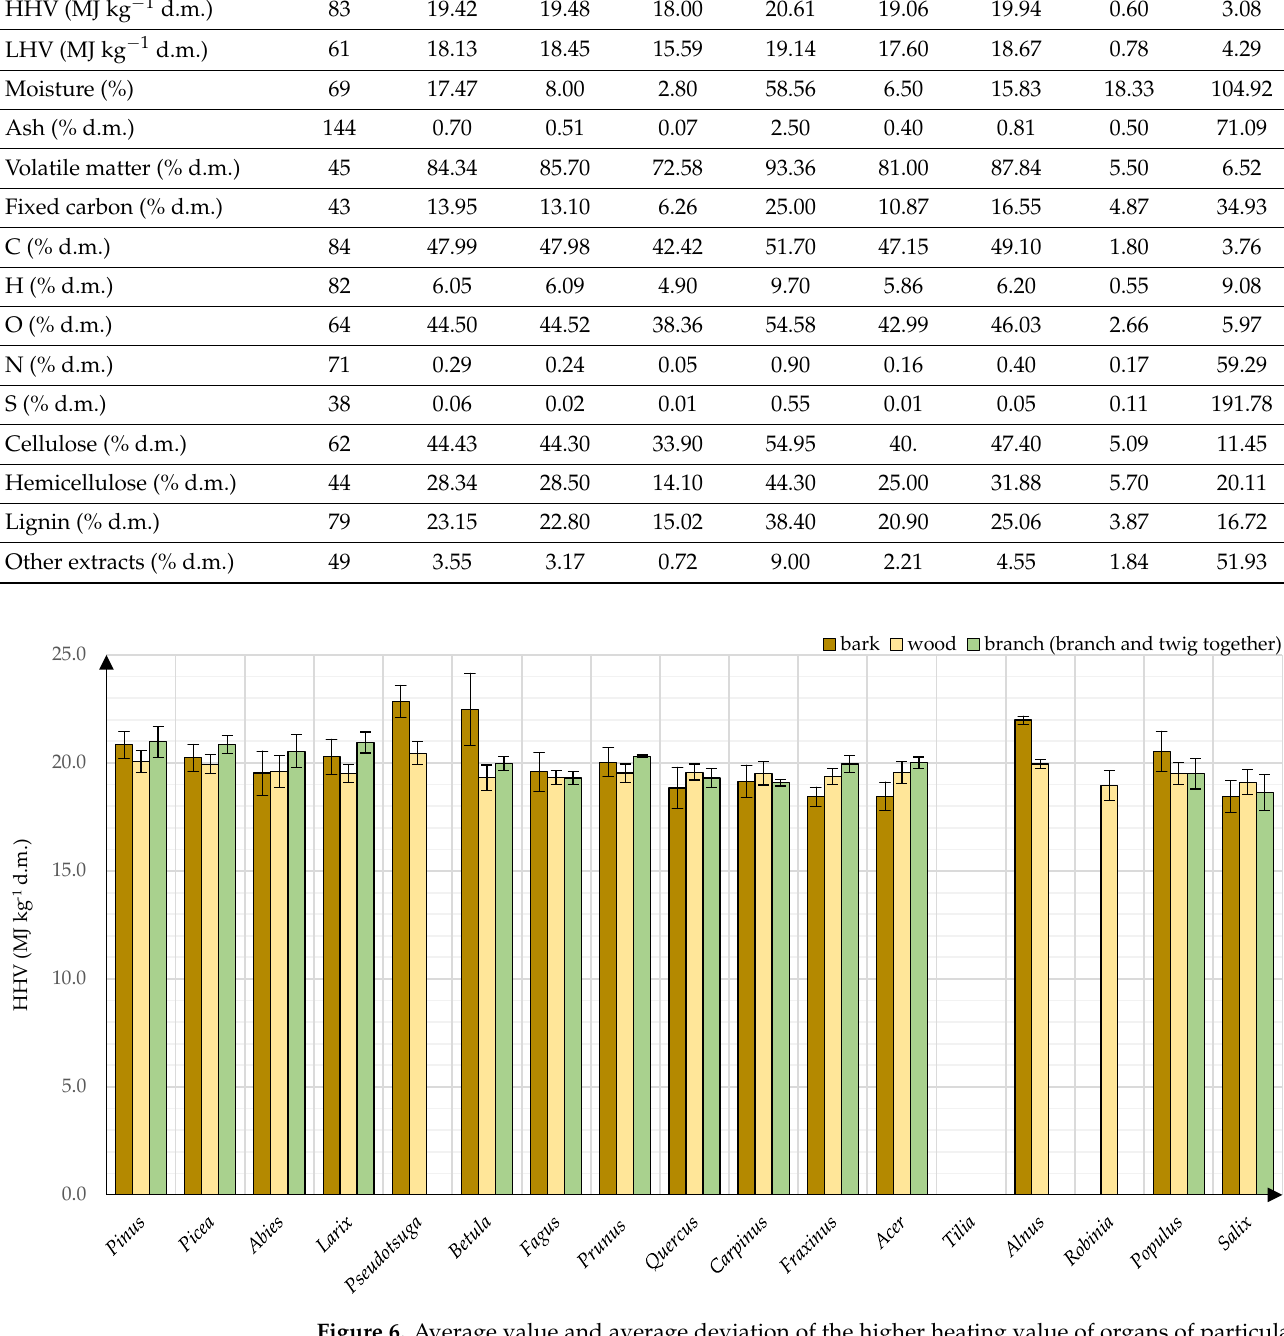
Figure 6. Average value and average deviation of the higher heating value of organs of particular systematic genera trees.